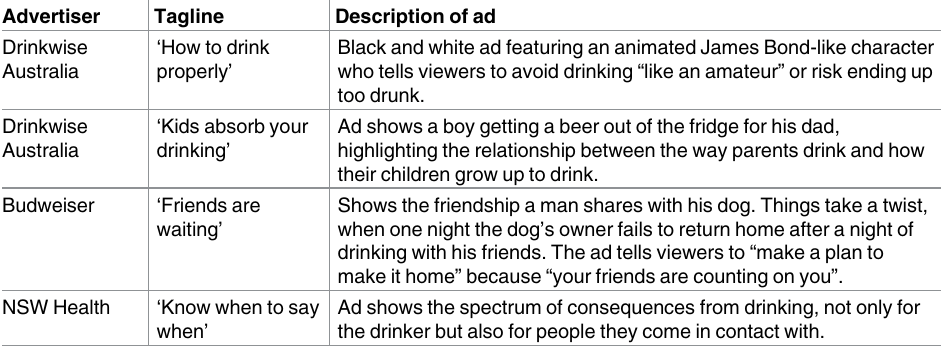
Table 1. Description of advertisements shown to respondents (Study